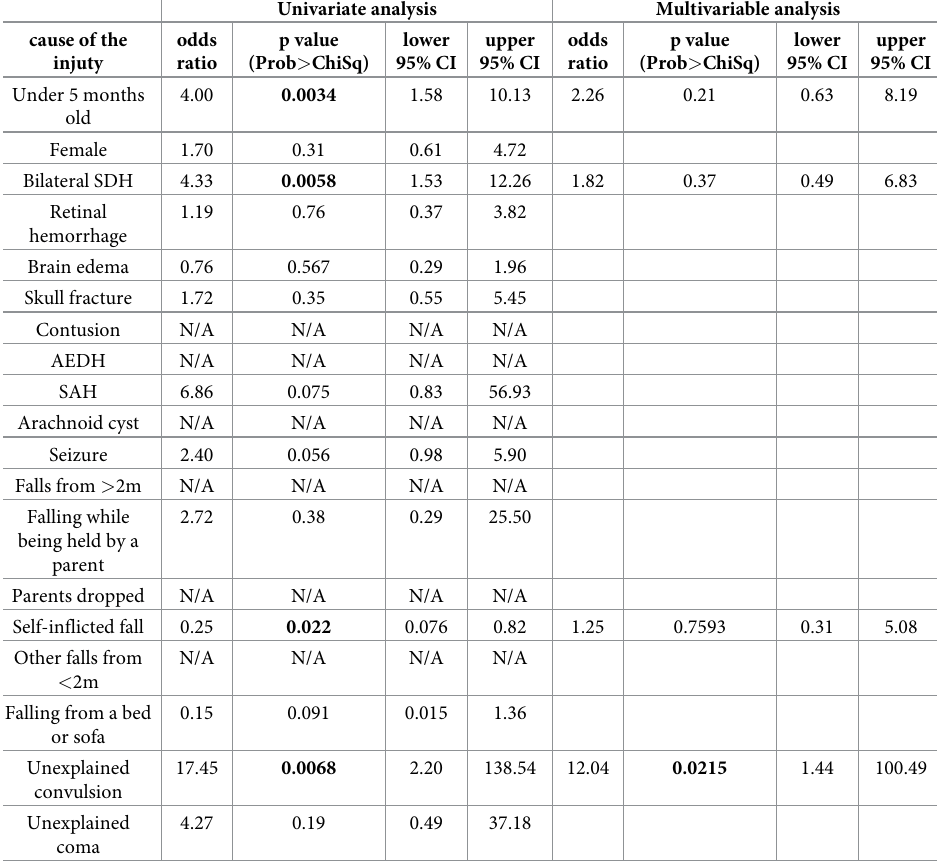
Table 4. Results of univariate and multivariable analyses to examine the relationship between nonaccidental injury and prognostic